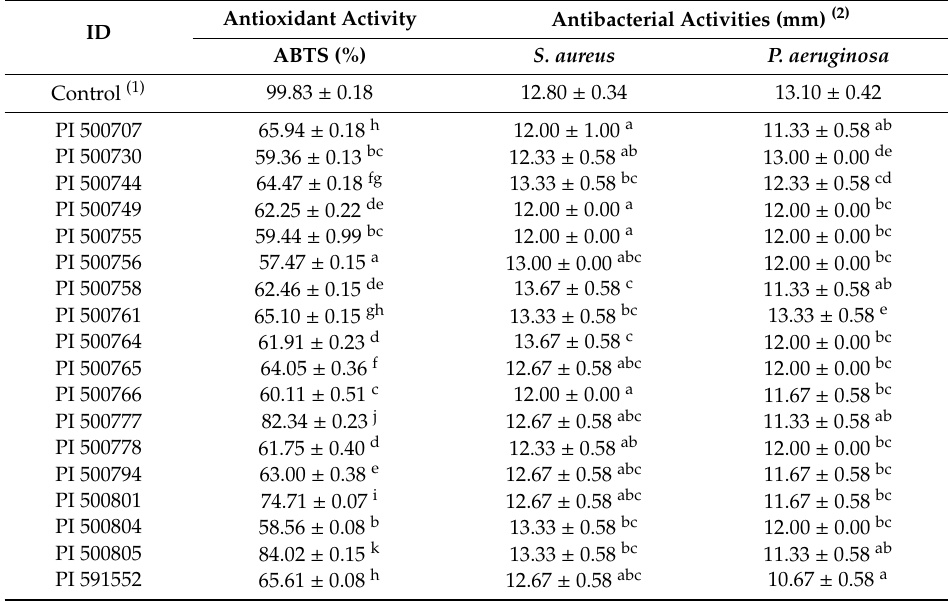
Table 3. Antioxidant and antibacterial activities of 18 di ff erent H. acetosella